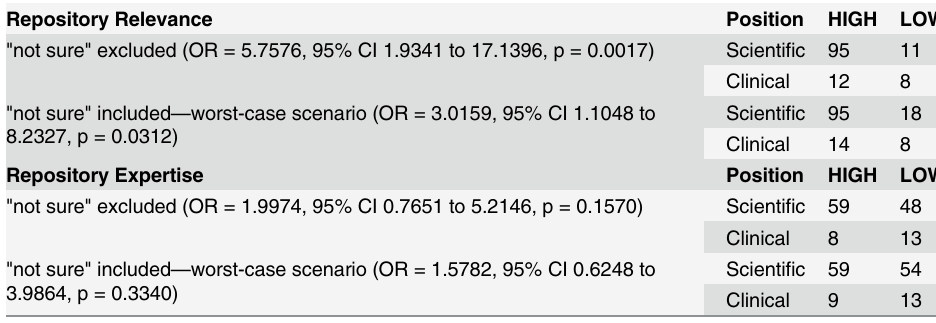
Table 6. Comparison of initial analyses with worst-case scenario